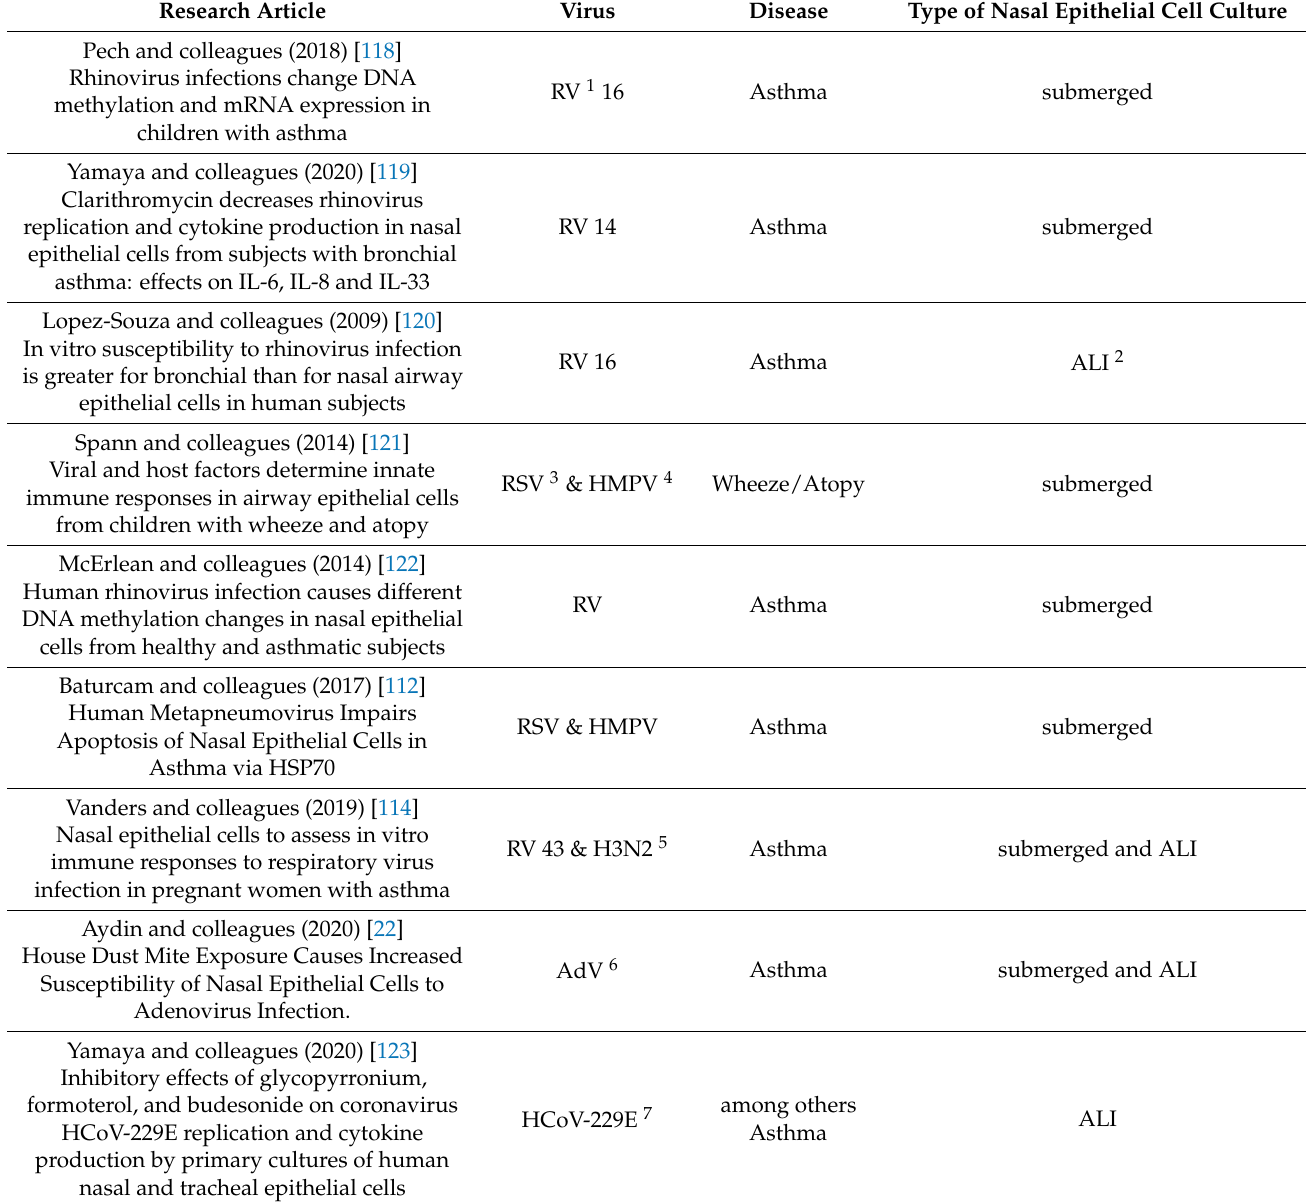
Table 1. Overview of published research articles associated with nasal epithelial cell culture models, asthma, and virus